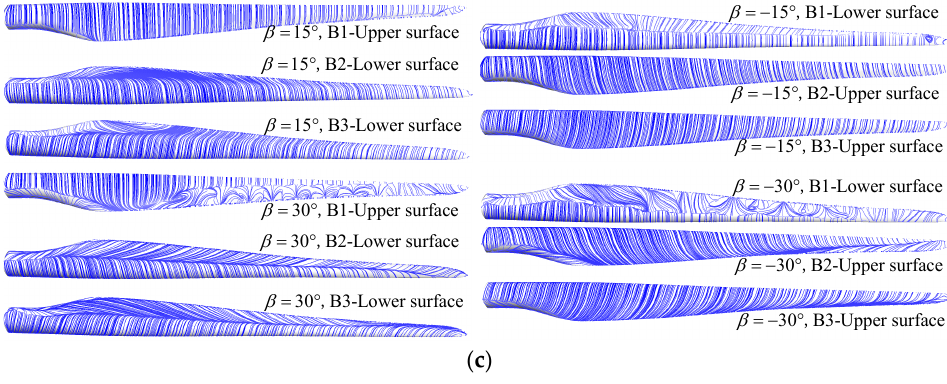
Figure 4. The streamline on the leeward side of the blade: ( a ) = 0 parking position; ( b ) = 30 parking position; ( c ) = 60 parking position.